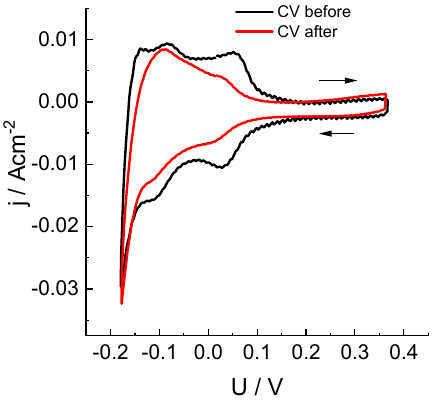
Figure 4. Study of electrochemical adsorption/desorption of hydrogen on a Pt/C anode catalyst (see Figure 1 for information) before and after five potentiostatic load tests at 0.7 V (see Figure 3 and Table 1) by means of cyclic voltammetry: voltage sweep rate: 50 mV/s, sweep limits: − 0.18 to 0.37 V. Voltage was measured between the cathode in contact with the half-reduced solution of 0.15 M 2,7- Na 2 AQDS (1 M H 2 SO 4 ) and the anode with a Pt/C catalyst in an argon atmosphere.